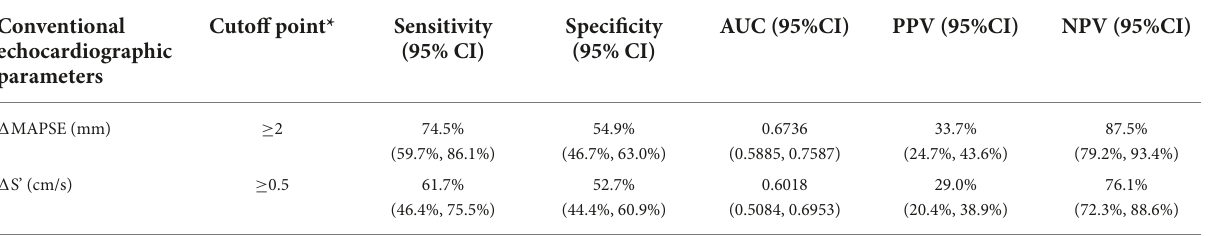
TABLE 2 ROC analysis for conventional echocardiographic